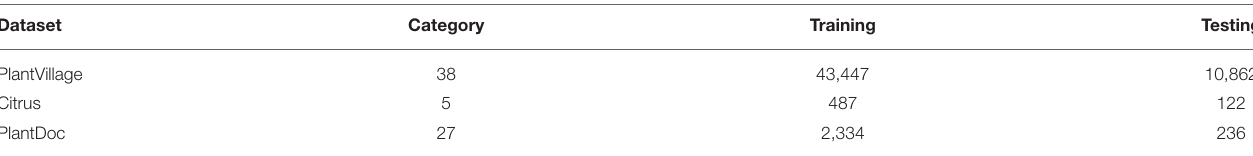
of our proposed network on PlantVillage, Citrus, and PlantDoc data sets is 98.04, 98.36, and 90.16% respectively. The test of MDAM-DRNet using the laboratory data sets revealed a good recognition effect, which is equivalent to the recognition accuracy of an advanced network. The recognition accuracy on the non-laboratory data set (PlantDoc) was > 90%, exceeding that of the other model networks, indicating that this paper’s proposed network is applicable to real-world